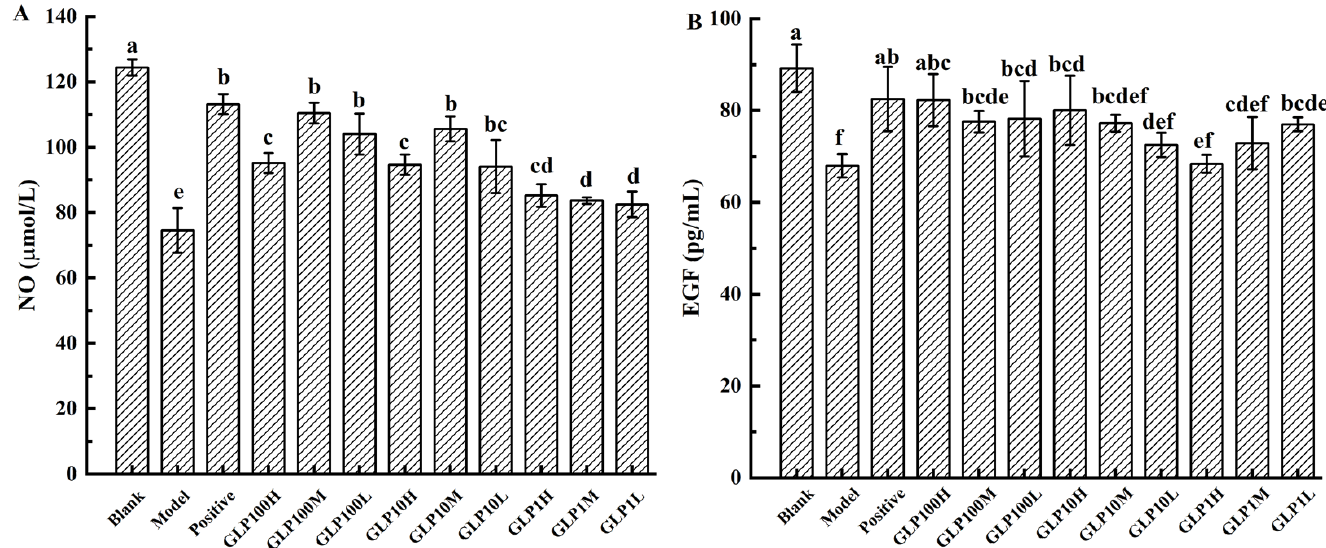
Figure 4. Effects of GLPs on the contents of NO ( A ) and EGF ( B ) in rats. Different lowercase letters (a – e) indicate significant differences at p < 0.05. (a–e) indicate significant differences at p <